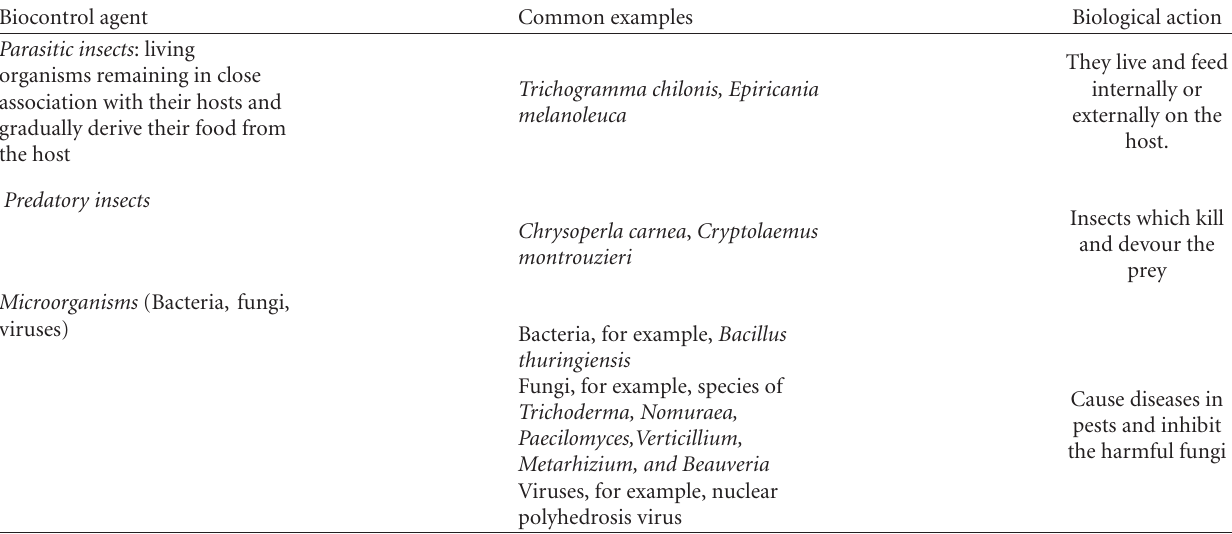
Table 1: Di ff erent types of organisms including pathogenic microorganisms such as viruses, bacteria, fungi, protozoa, and nematodes have been used as biocontrol agents.